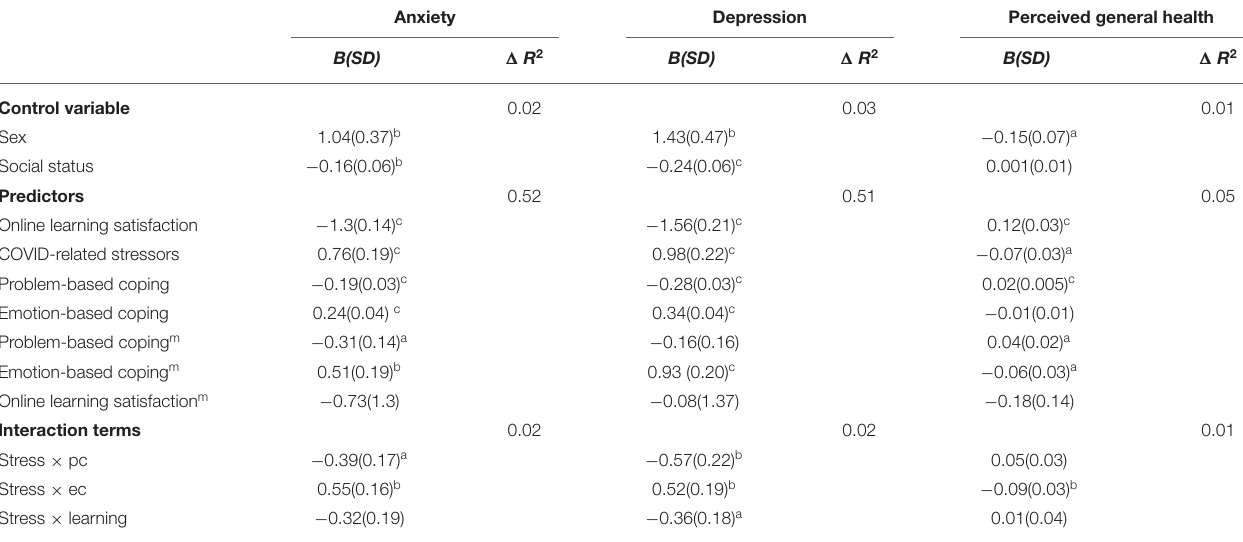
TABLE 2 | Hierarchical linear analysis of the studied constructs among Chinese adolescents during the